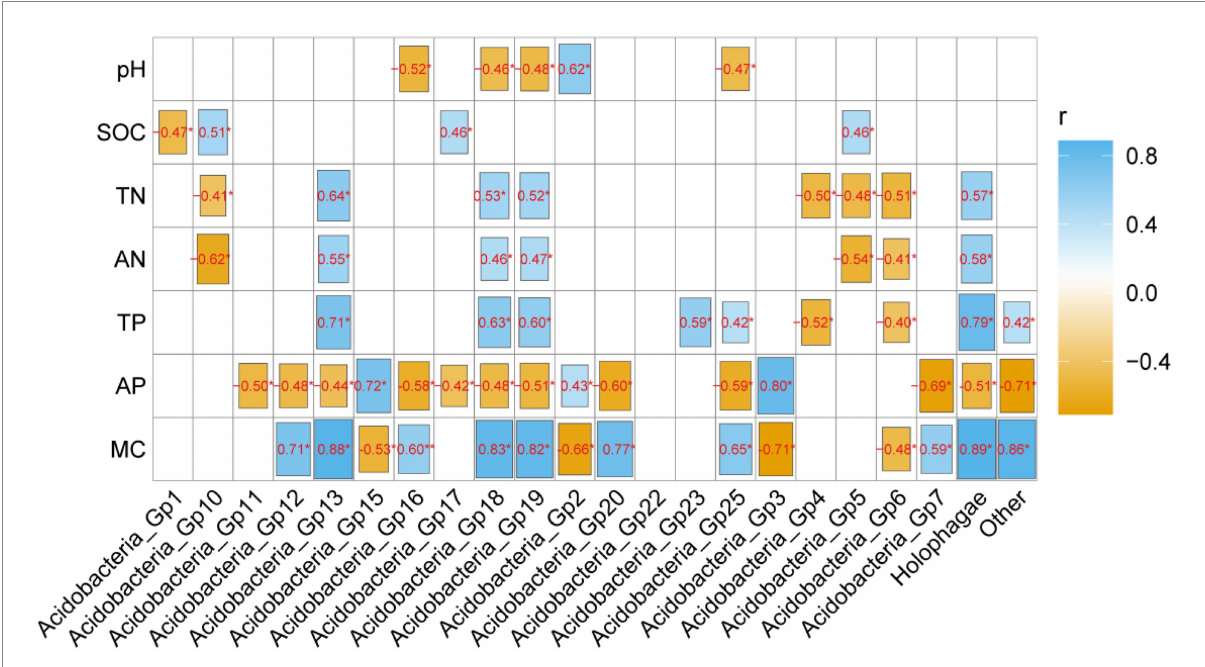
FIGURE 4 The correlation analysis of soil physicochemical properties and Acidobacterial subgroups. Blue colors indicate positive and yellow colors negative correlations. *, **, and*** mean 0.05, 0.01, and 0.001 levels,